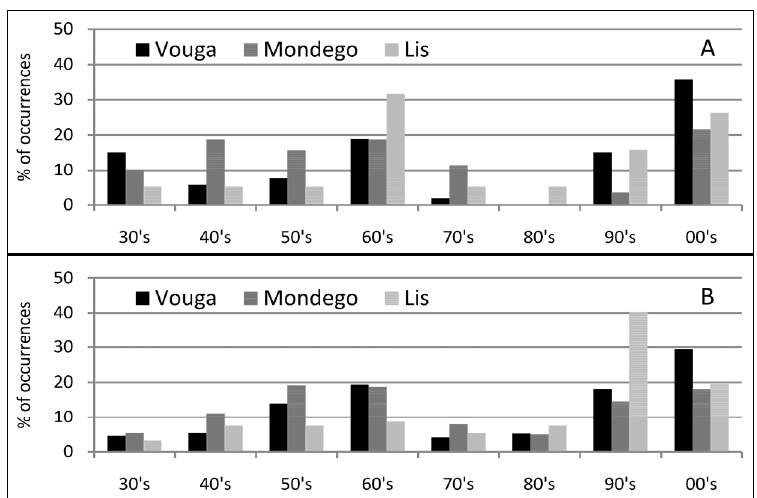
Figure 2. Relative frequencies by decade of the No. of occurrences with human consequences (OHC) ( A ); and No. of occurrences with only material consequences (OMC) ( B ). Figure 2B confirms the general existence of two periods with a high No. of OMC: the 1950s and 1960s, and the 1990s and 2000s. The relevance of these last two decades is especially notable in the Vouga and Lis basins.